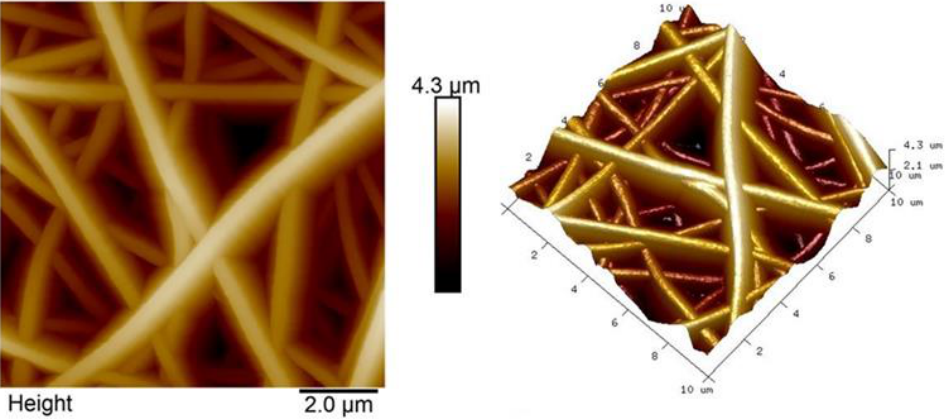
Figure 3. AFM images of 2D and 3D surface topography of PAN-PMMA electrospun fibers.